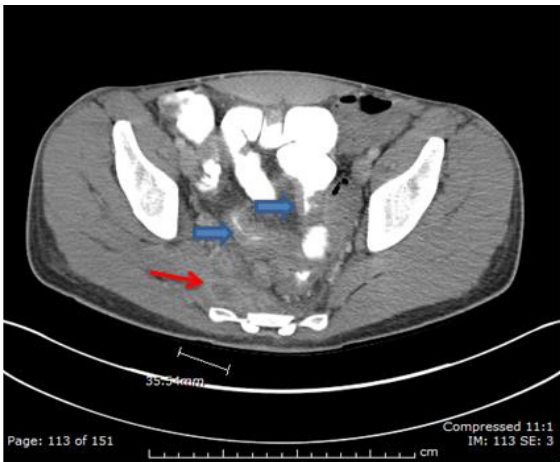
Figure 1. Axial computed tomography of the pelvis with oral and intravenous contrast material, at the level of the greater sciatic fora- men, demonstrating a sinus tract extending to the right piriformis (red arrow), originating from a segment of the distal ileum (not shown). Segmental, transmural distal ileal wall thickening is also shown (blue arrows). Patient also has multiple ileocolic fistulae (not shown).